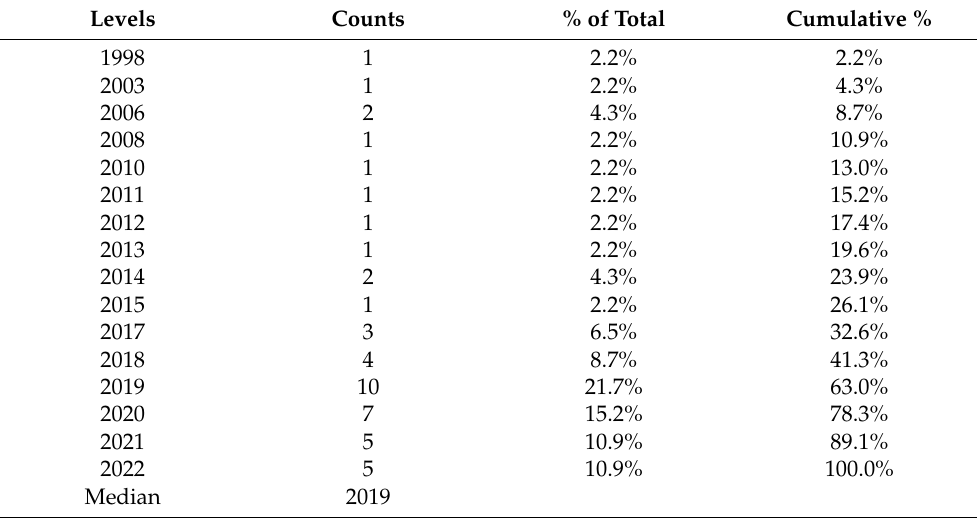
Table 1. Breakdown of Articles by Year of Publication.